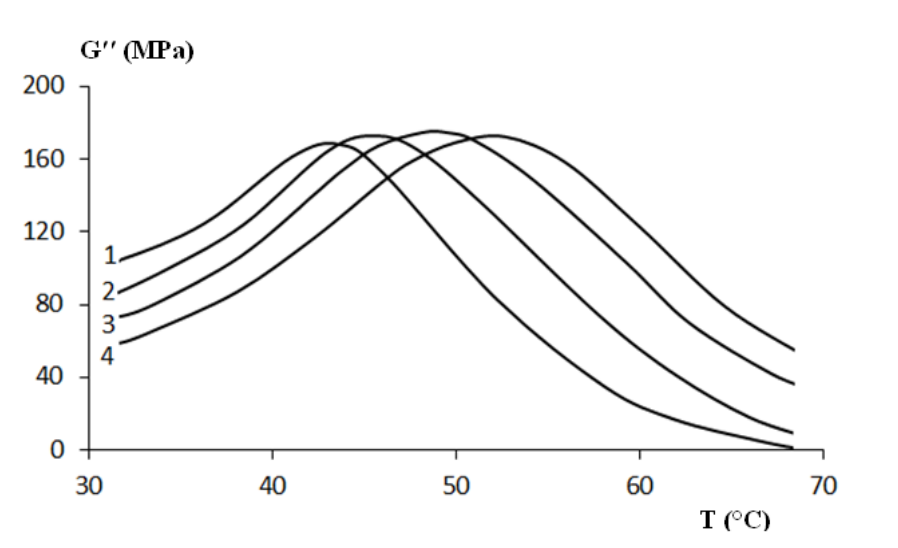
Figure 14. Multi-frequency 3 point bending dynamic mechanical analyzer (DMA) test on